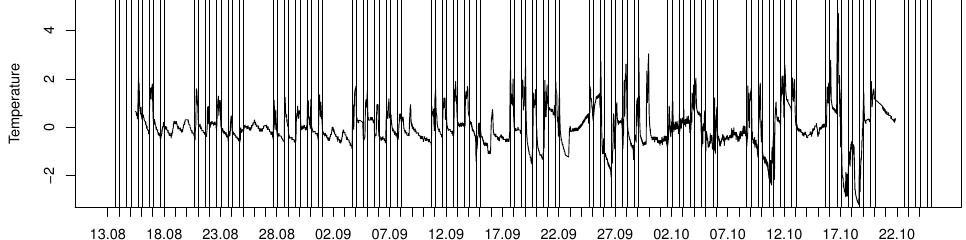
Figure 6. The temperature time series with removed seasonal change